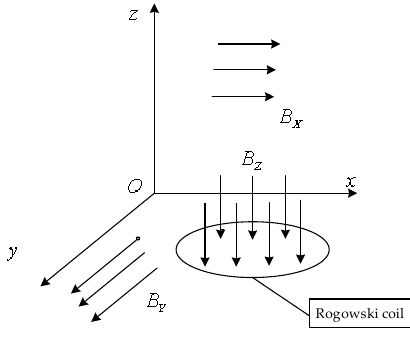
Figure 4. The impact of orthogonal magnetic field.